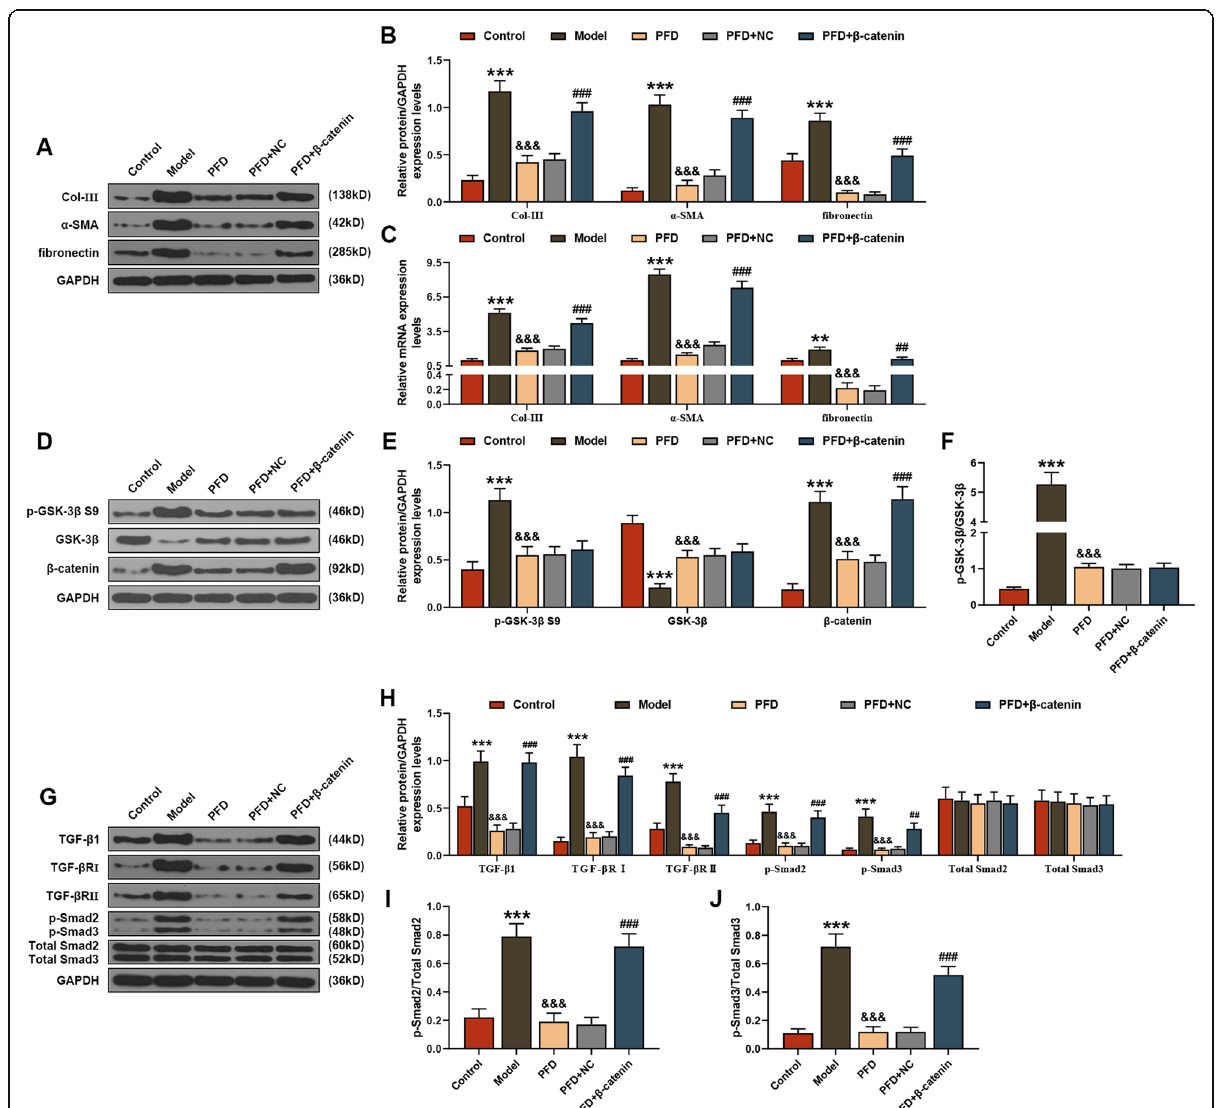
Fig. 2 Pirfenidone (PFD) played an anti-pulmonary fibrosis role by regulating Wnt/GSK-3 β / β -catenin and TGF- β 1/Smad2/3 signaling pathways. In this figure, mice ( n = 30) were randomly divided into equal 5 groups: control, model (Bleomycin (BLM)), PFD, PFD + negative control (NC), and PFD + β -catenin. The mRNA and protein levels of collagen (Col)-III, α -SMA and fibronectin in lung tissues were determined by ( a , b ) Western blot (WB) and ( c ) quantitative real-time polymerase chain reaction (qRT-PCR) assays. The protein levels of factors associated with ( d - f ) Wnt/GSK-3 β / β - catenin (p-GSK-3 β S9, β -catenin) and ( g - j ) TGF- β 1/Smad2/3 (TGF- β 1, TGF- β R Ι , TGF- β R ΙΙ , p-Smad2/3) signaling pathways were measured by WB assay. ** P < 0.01, *** P < 0.001, vs. control; &&& P < 0.001, vs. model; ## P < 0.01, ### P < 0.001, vs. PFD + NC. N =